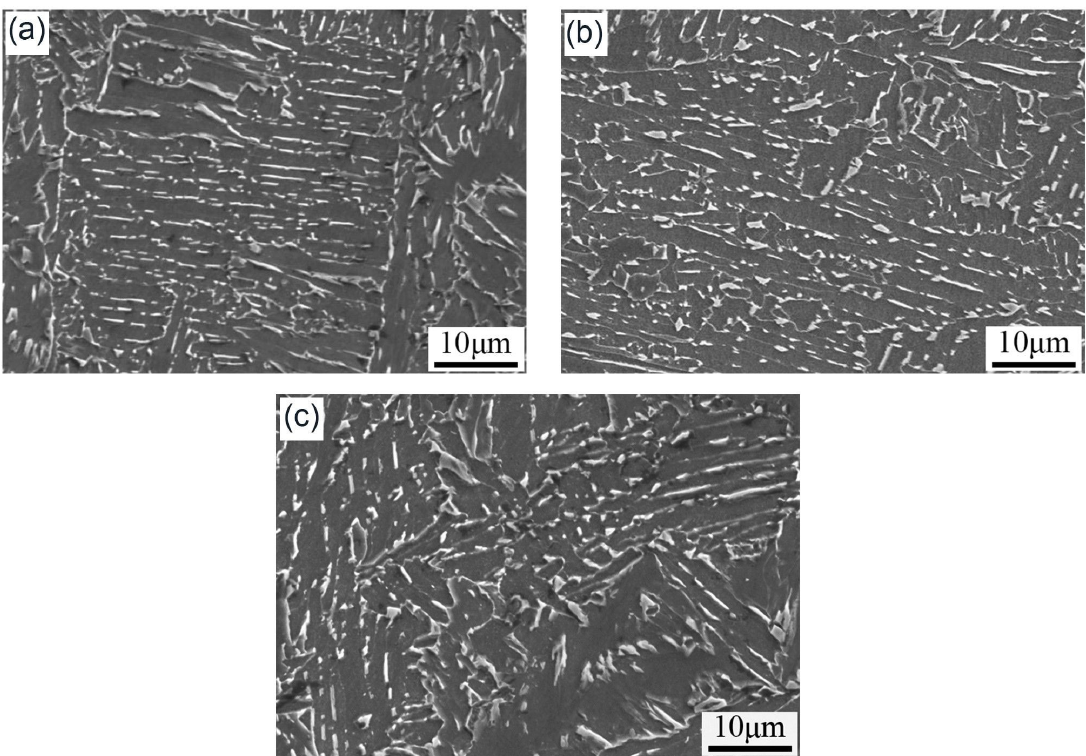
Figure 2. SEM morphology in CGHAZ of welded joint under different the welding heat input: (a) 18kJ·cm -1 , (b) 24kJ·cm -1 and (c)30kJ·cm -1